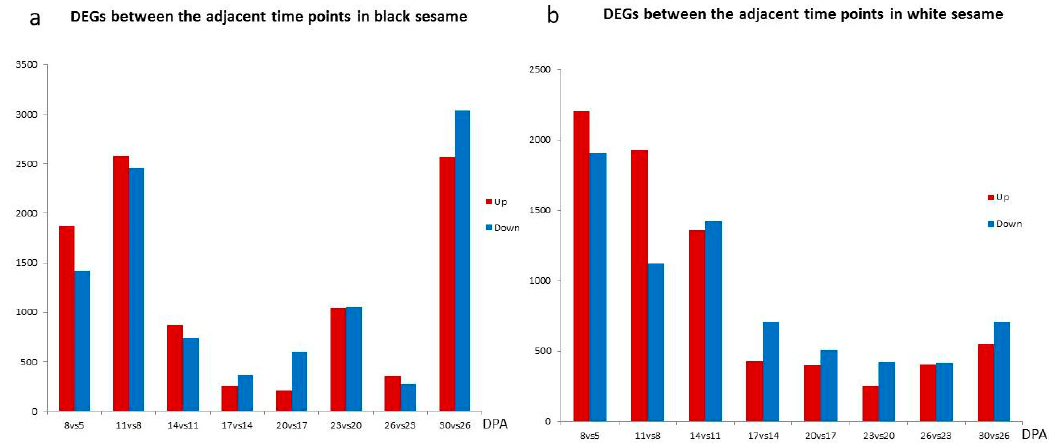
Figure 4. Dynamic change of the di ff erentially expressed genes in black ( a ) and white ( b ) sesame seeds. To identify the functional categories of the DEGs between the black and the white sesame, we performed the GO term analysis at different DPA. The DEGs between black and white sesame were enriched into 92 GO terms. Interestingly, only two GO terms were enriched at 5 and 23 DPA. However, several enriched terms in the molecular functions, biological process, and cellular component categories highlighted the 8–20 DPA. Mostly, oxidoreductase activity (GO:0016491), catalytic activity (GO:0003824), iron ion binding (GO:0005506), monooxygenase activity (GO:0004497), electron carrier activity (GO:0009055), heme-binding (GO:0020037) were enriched four or five times from 8 to 20